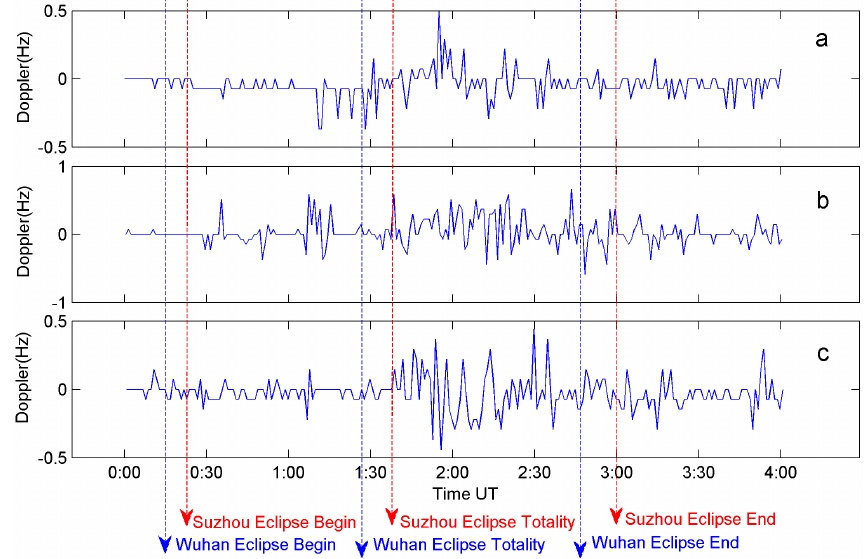
Fig. 3. The temporal variation of DFS of one-hop wave reflected by Es recorded by the Suzhou receiver at (a) 6.6, (b) 8.2 and (c) 10.6MHz on 22 July 2009. The solar eclipse beginning, totality and end time of Wuhan and Suzhou is marked by blue and red lines, respectively.